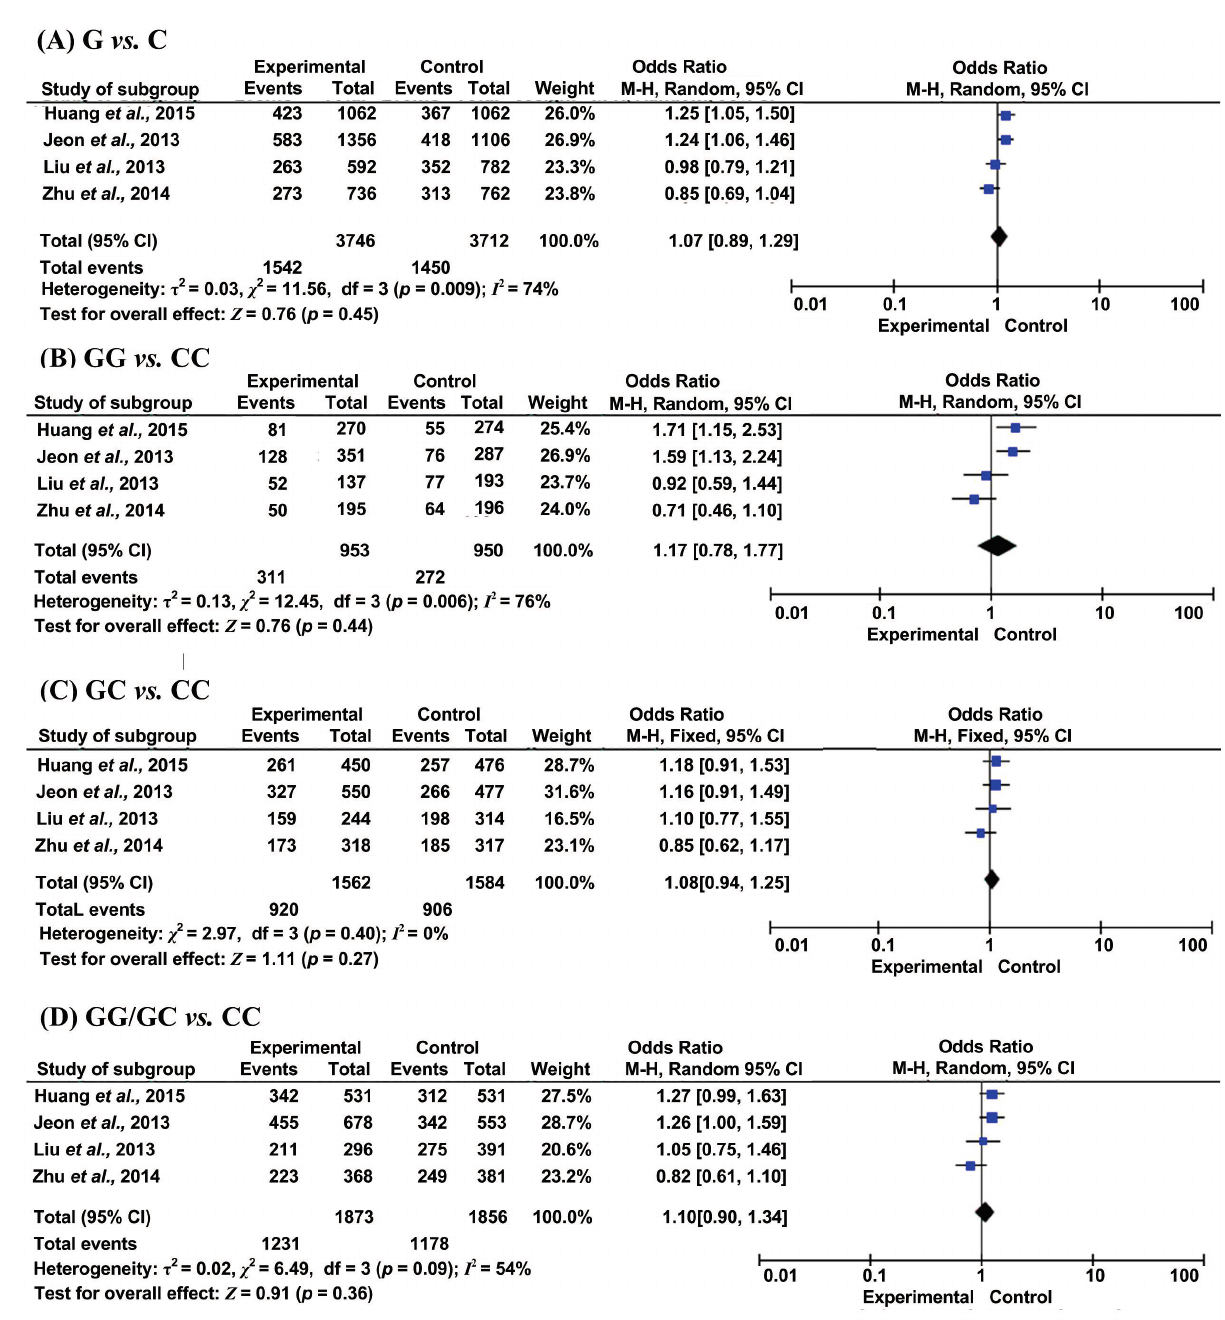
Figure 3. Forest plots of odds ratios for the association between microRNA-146a rs2910164 and risk of IS. ( A ) G vs . C; ( B ) GG vs . CC; ( C ) GC vs . CC; ( D ) GG/GC vs .